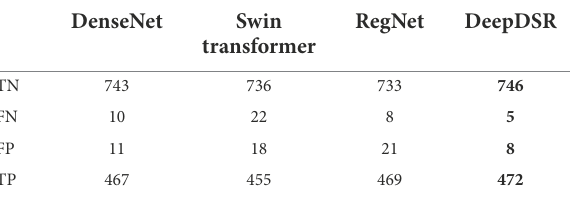
TABLE 5 Statistical analyses of four models on 1,231 images.